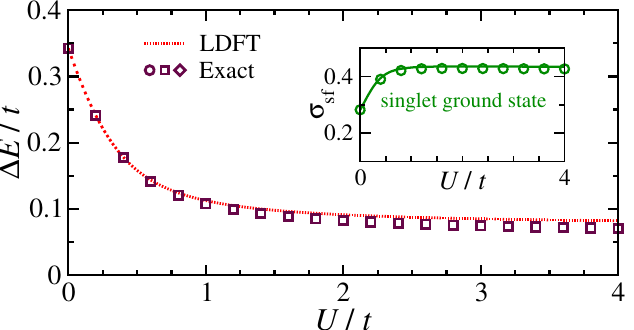
Figure 3. Singlet-triplet gap ∆ E and ground-state degree of spin fluctuations σ sf in a half-filled Anderson ring having N o = 12 orbitals, ε f = 0 and V sf / t = 0.4. The results obtained with the TLA (curves) are compared with exact Lanczos diagonalizations (symbols) as a function of the Coulomb-repulsion strength U / t at the impurity orbital. Reproduced with permission from Reference [77]. c (cid:13) American Physical